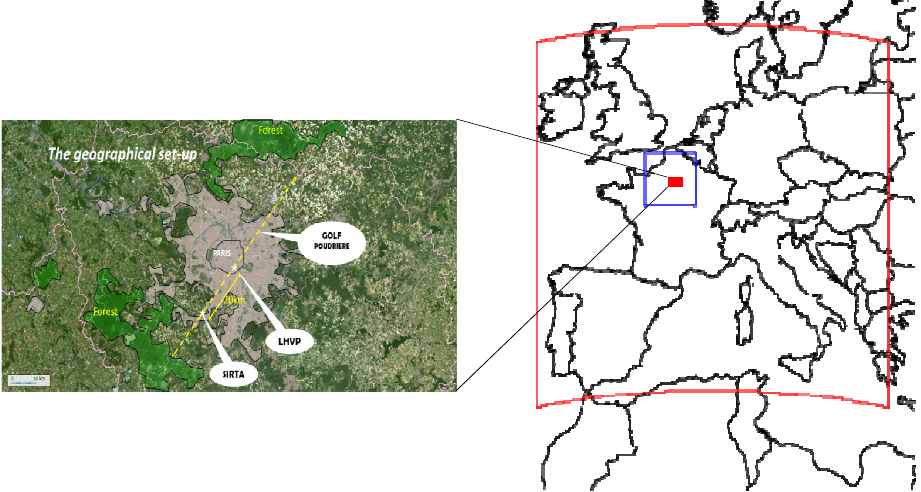
Fig. 1. Location of the urban and the two suburban sites (left) and the simulation domain (right); the European CONT3 domain (in red), the nested Northern France MEG3 domain (in blue), and the Greater Paris region (indicated by a red rectangle). The yellow dashed line corresponds to the major SW and NE wind directions prevailing in the region. Table 2. Meteorological and chemical instruments deployed at the three main measurement